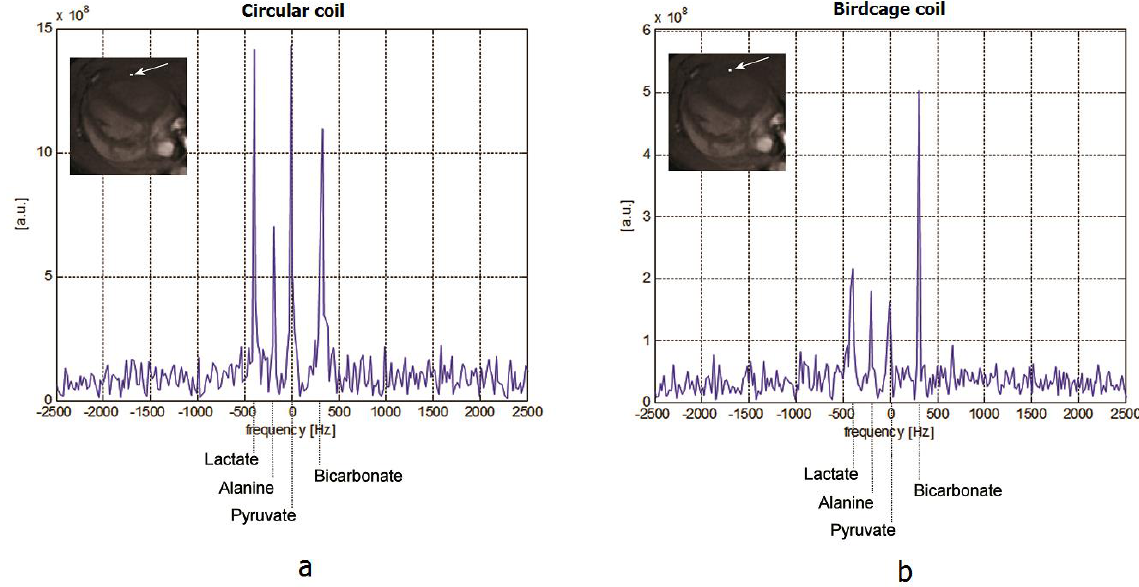
Figure 7. Hyperpolarized 13 C spectra acquired with the circular coil ( a ) and the birdcage coil ( b ). Adapted by permission from: Giovannetti et al., App Magn Reson 2012 [18].